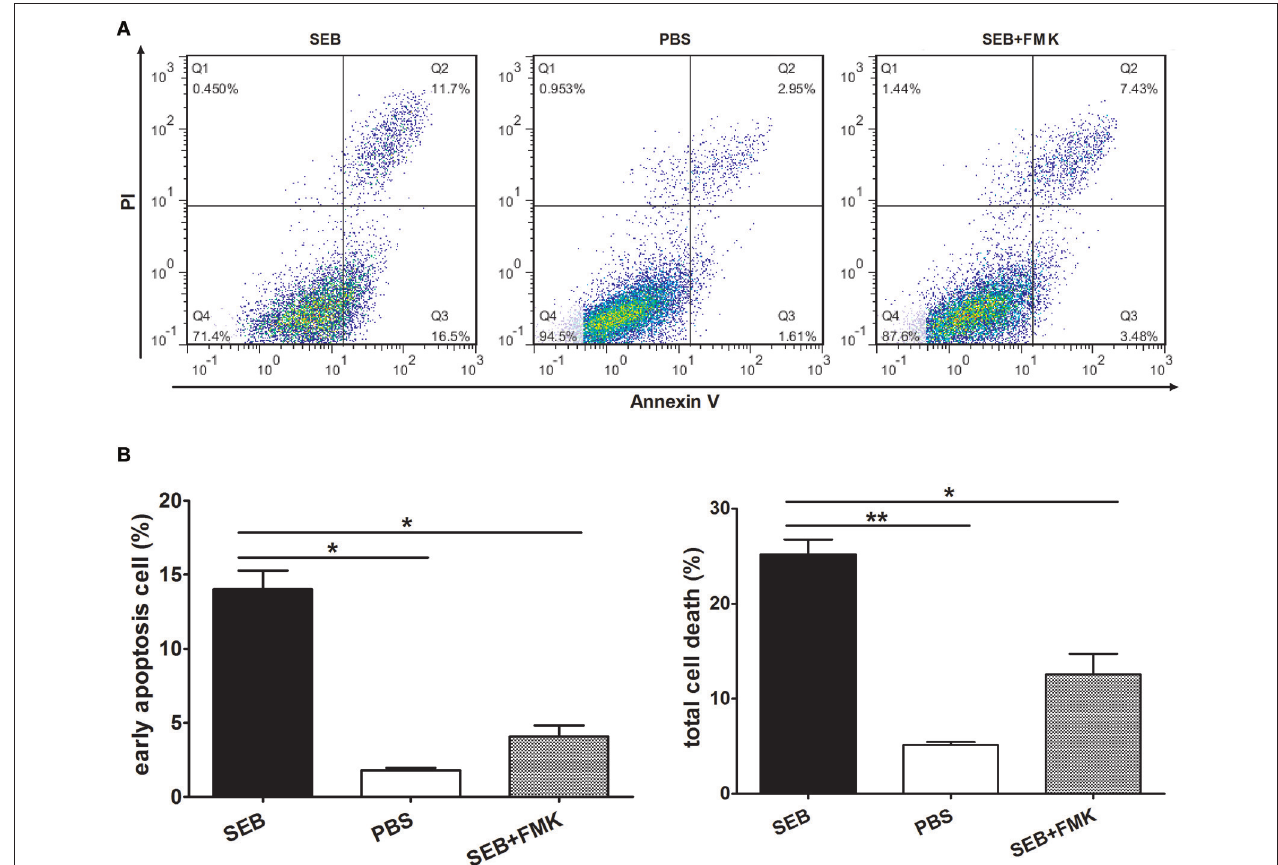
FIGURE 2 | SEB induced apoptosis in differentiated THP-1 cells. Cells were inoculated in 24-well-plates (2 × 10 5 per well) and pre-treated with 30nM PMA for 48h. After the medium was changed with a fresh culture medium, the cells were then treated with 20 µ g/ml (24 µ l/well) SEB with (striped bar) or without (black bar) 20 µ M (2 µ l/well) Z-VAD-FMK and 24 µ l/well PBS (white bar) for 36h. (A) Apoptosis was measured through Annexin V/PI staining and flow cytometry. (B) Quantitatively analyzed data are presented as means ± S.D . ( n = 3), *indicated P < 0.05 and **indicated P < 0.01.